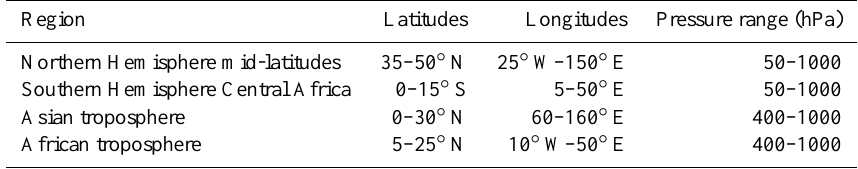
Table 1. Latitudes, longitudes and pressures used to define regions of TTL air mass origins (see text for